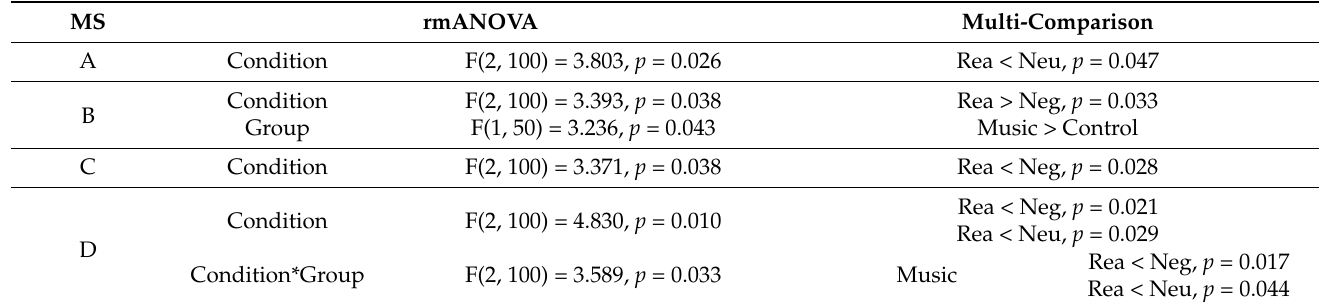
Figure 4. Dynamic time windows of microstates under the GFP curve. Table 1. The significant rmANOVA results of microstate